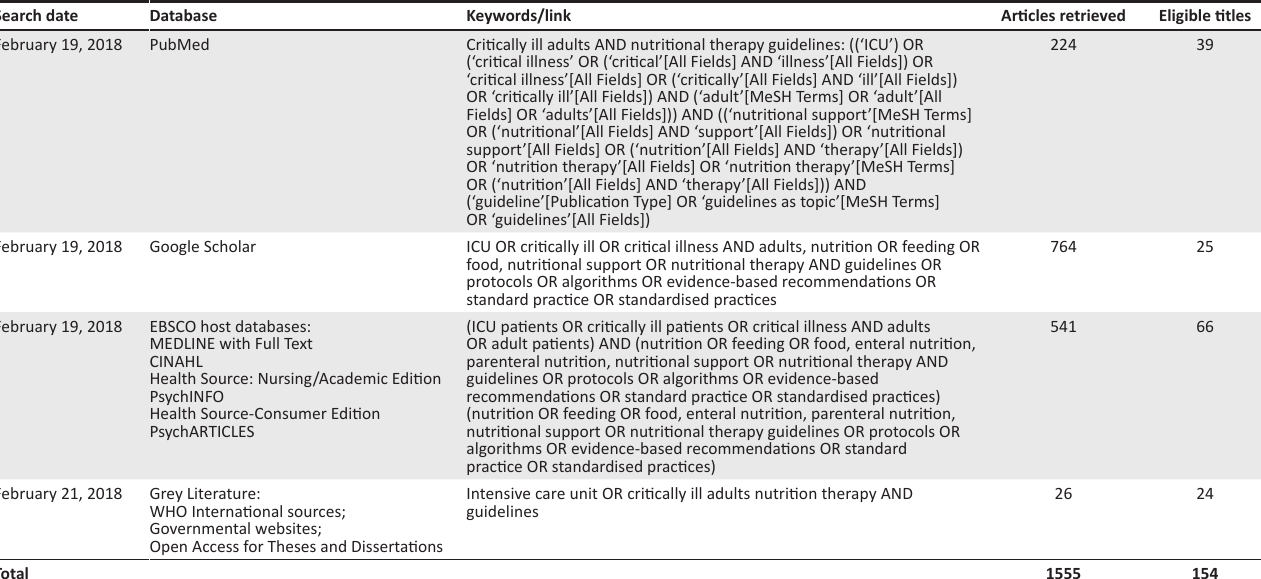
TABLE 2: Search terms per